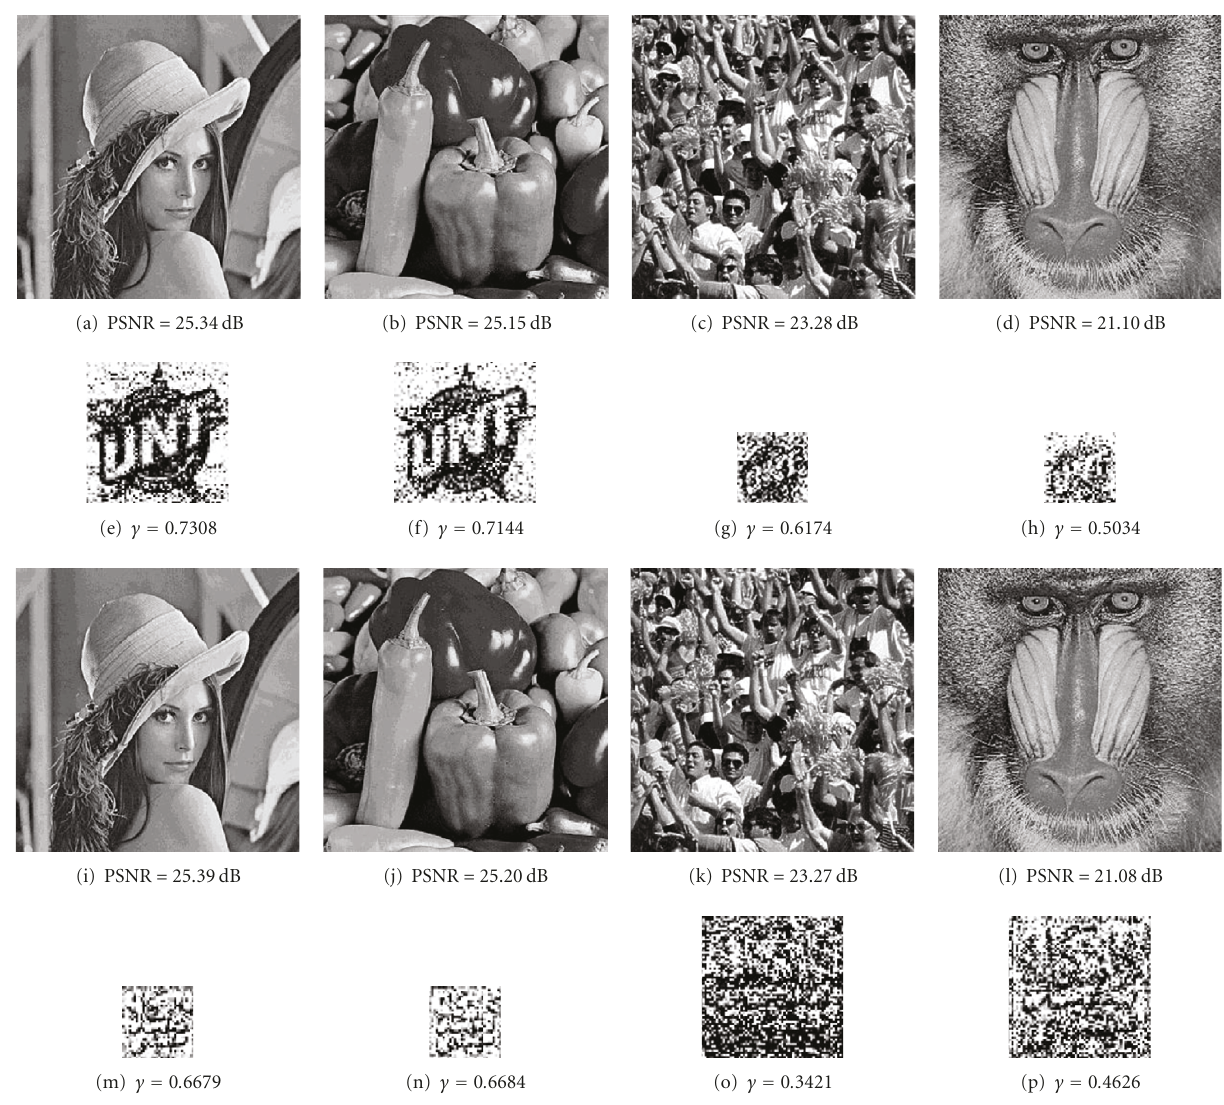
Figure 21: (a) and (b) Lena and Peppers watermarked images with 256 × 256 watermark image as shown in Figure 11(b) after Sharpening, (e) and (f) the extracted watermarks with size 256 × 256 from (a) and (b), respectively. (c) and (d) Crowd and Baboon watermarked images with 128 × 128 watermark image as shown in Figure 11(b) after Sharpening, (g) and (h) the extracted watermarks with size 128 × 128 from (c) and (d), respectively. (i) and (j) Lena and Peppers watermarked images with 128 × 128 watermark image as shown in Figure 11(d) after Sharpening, (m) and (n) the extracted watermarks with size 128 × 128 from (i) and (j), respectively. (k) and (l) Crowd and Baboon watermarked images with 256 × 256 watermark image as shown in Figure 11(d) after Sharpening, (o) and (p) the extracted watermarks with size 256 × 256 from (k) and (l),